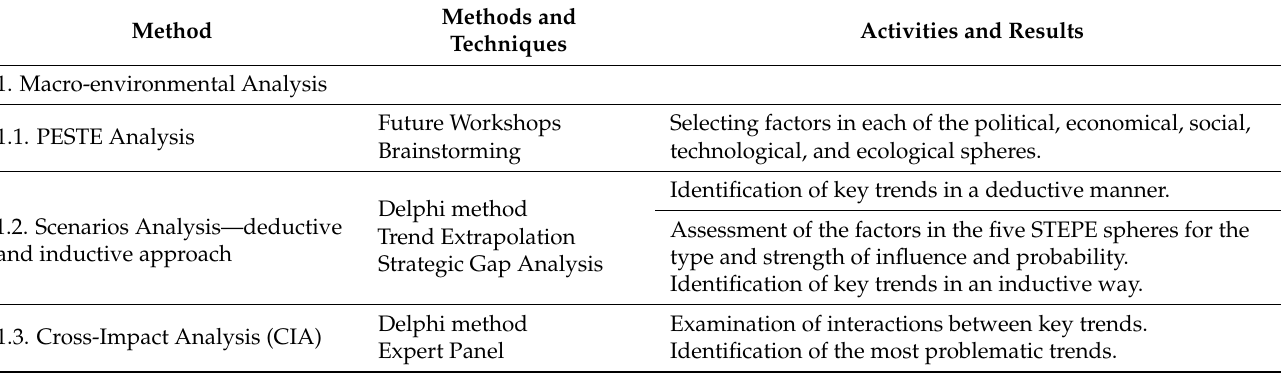
Table 5. Proposed concept for strategic analysis of energy